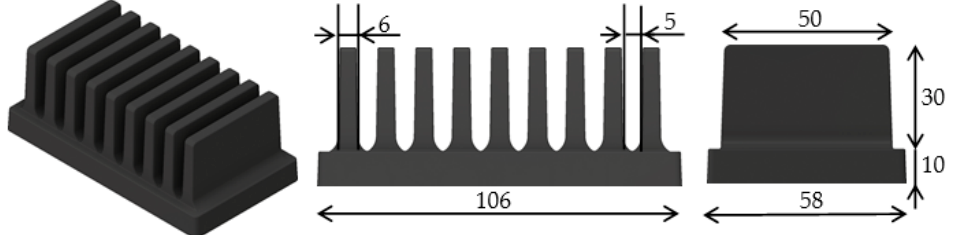
Figure 1 . Measured heat sinks’ geometry (dimensions are in